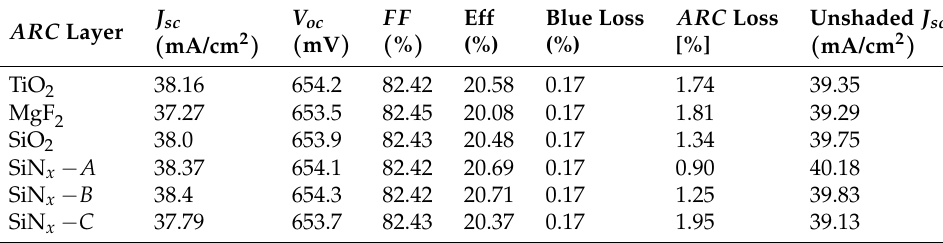
Figure 3. Reflectance spectra as a function of wavelength for some optimised single-layer anti- reflection coating. Table 1. I − V parameters and ARC loss calculation based on the different SLARC layers.